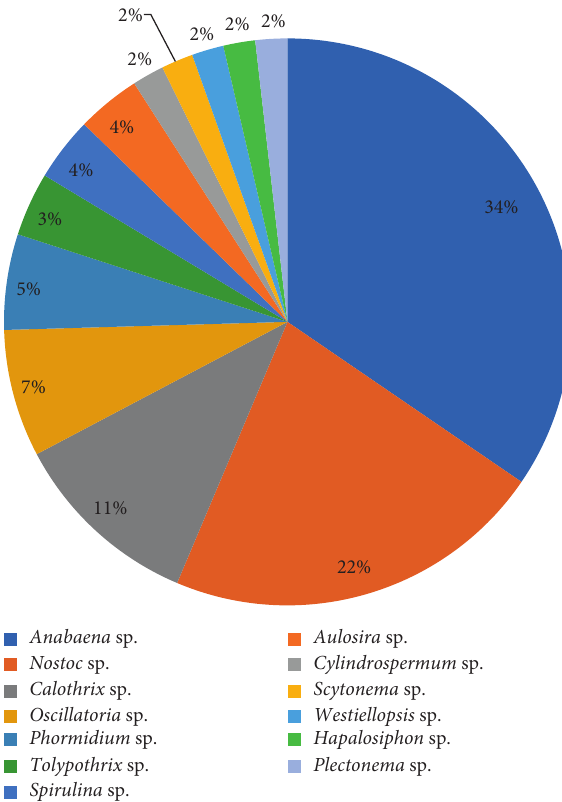
Figure 3: Most recurrent cyanobacteria genera in the articles reviewed. Source: own